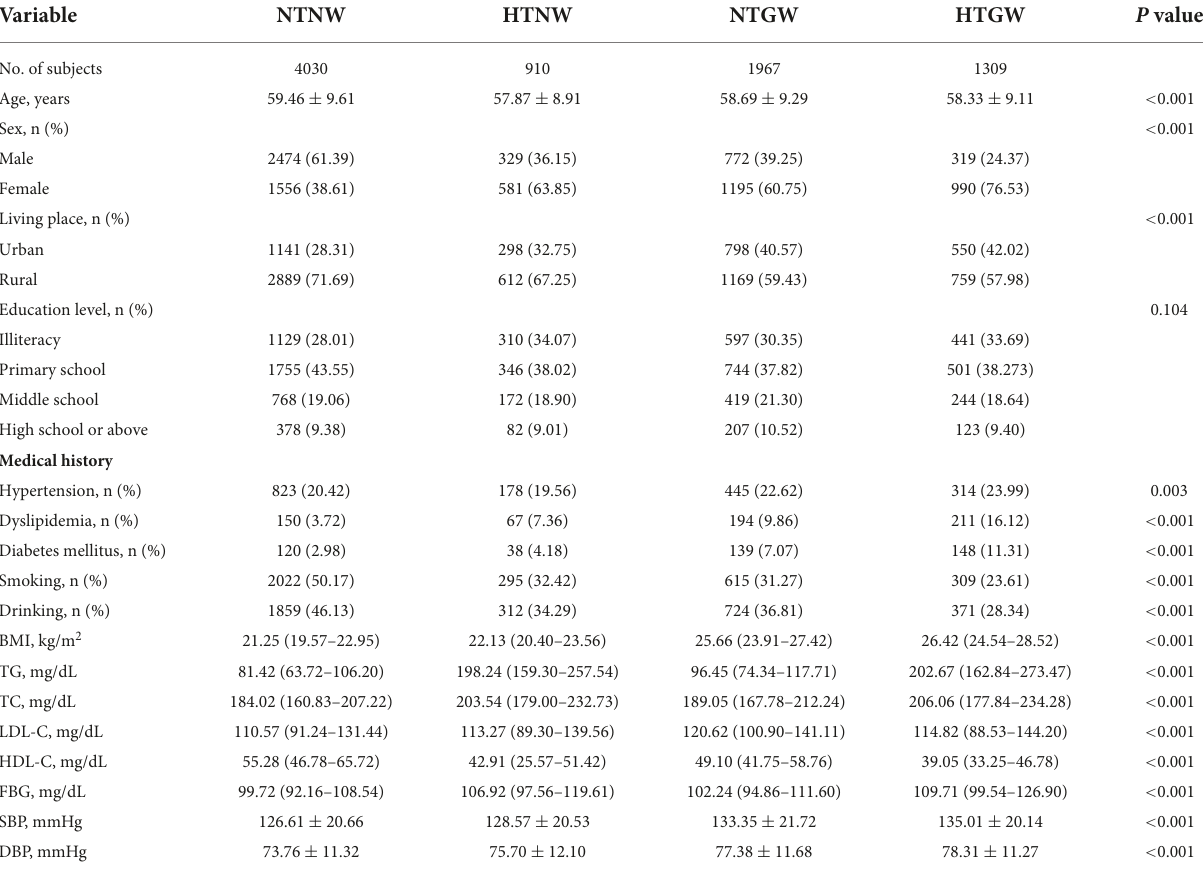
TABLE 1 Baseline characteristics of the study participants according to high triglyceride levels and enlarged waist circumference (HTGW) phenotype in baseline.